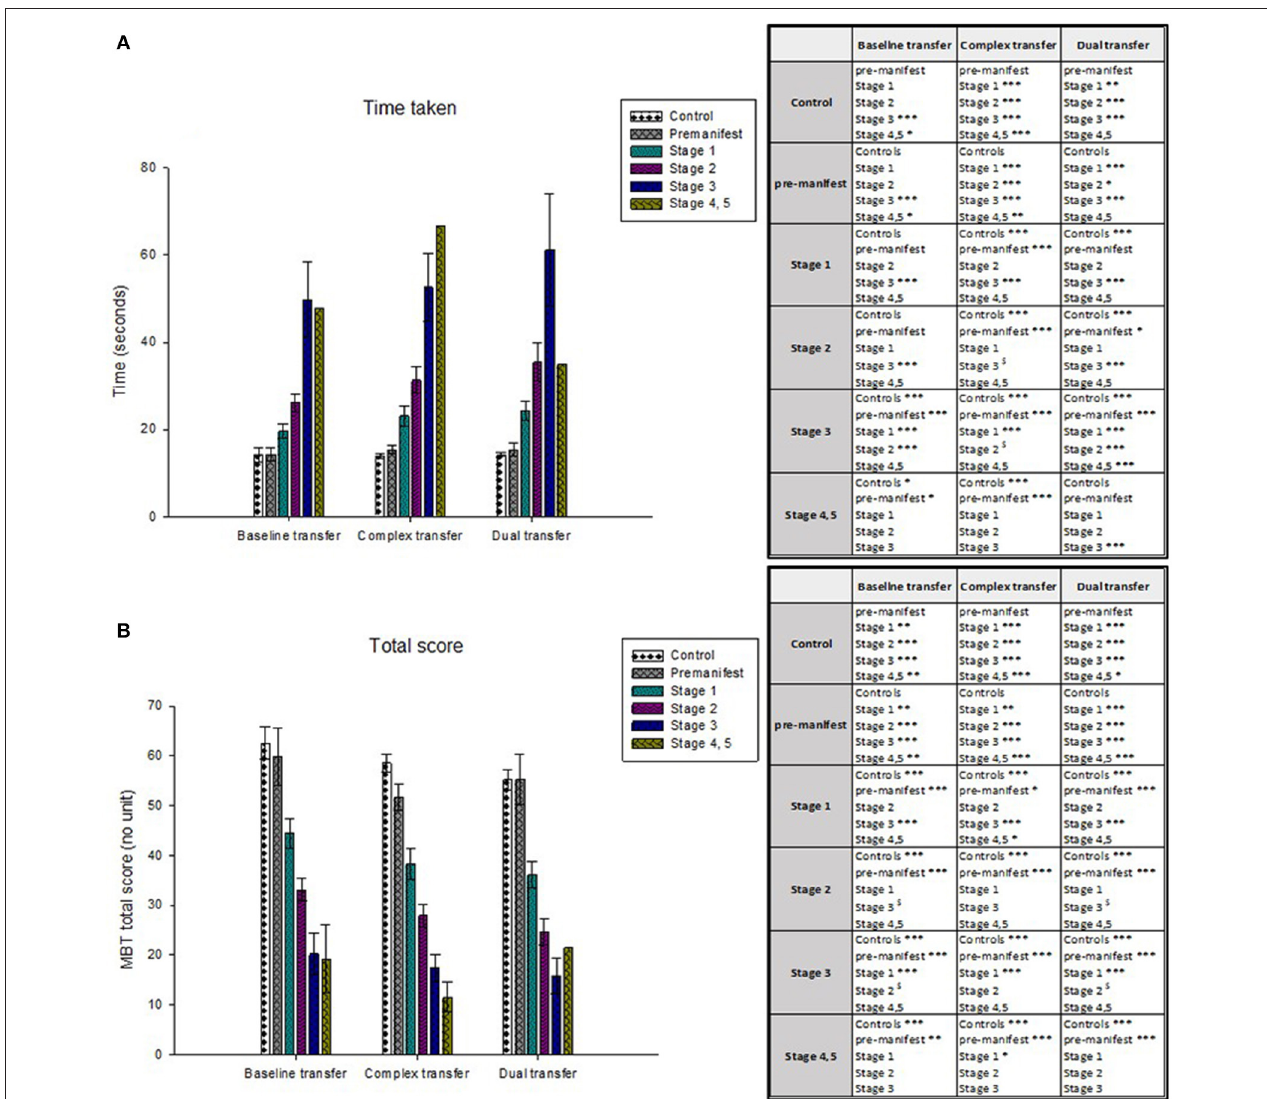
FIGURE 3 | The mean time taken is plotted in (A) and the mean MBT total scores are plotted in (B) . Healthy controls and people in the early disease stages (stage 1) performed the transfer tasks significantly faster than those in the later disease stages (stage 4, 5). The same stepwise performance deterioration is evident according to the MBT total scores, from which healthy controls and people in the early disease stages achieved a greater MBT total score (indicative of a faster time and greater accuracy) compared to those in the more advanced disease stages. Significant differences between participant groups are presented in the tables, where * p < 0.05, ** p < 0.01, *** p <